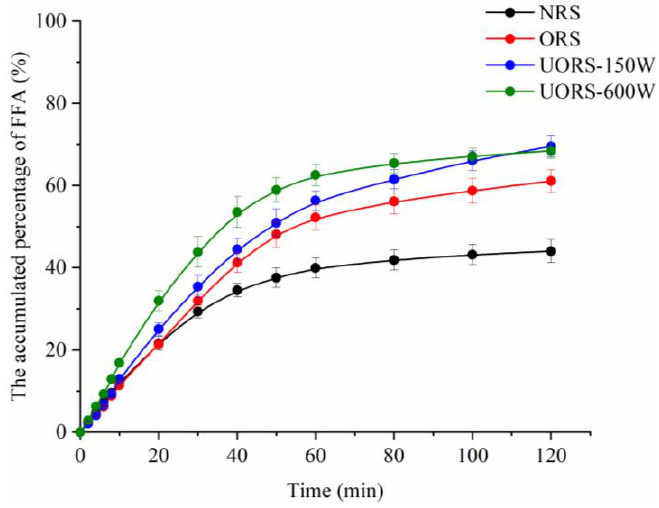
Figure 3. The accumulated percentage of free fatty acids (FFA%) released by curcumin emulsions stabilized by native rice starch and OSA rice starch in SIF.